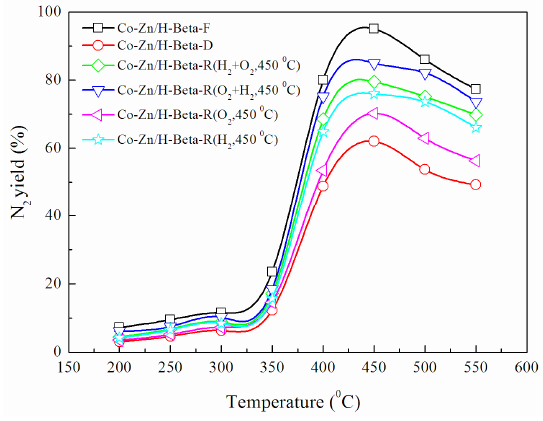
Figure 2. Optimization of regeneration sequence.